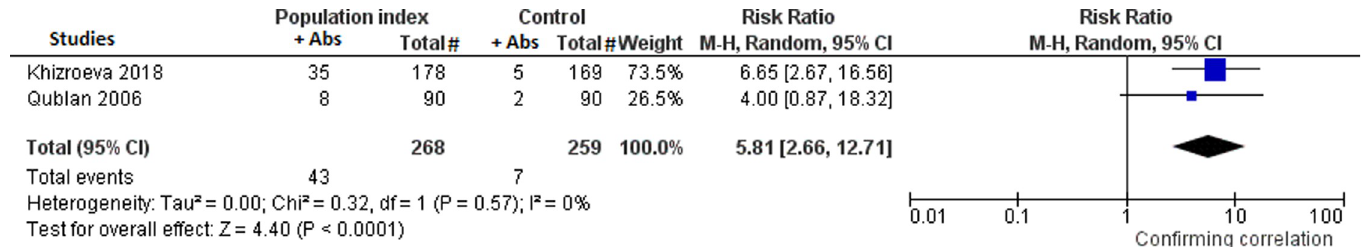
Fig 4. Meta-analyses assessing the risk for implantation failure in relation to the presence or not of anti-PL antibodies in the studies in subgroup A between women with at least two implantation failures in IVF-ET ( population index ) vs . women with one successful IVF-ET ( control ). Fig 4: meta-analysis assessing the risk for implantation failure in relation to the presence or not of LA antibodies. +Abs: positive antibodies, total #: total number of participants.